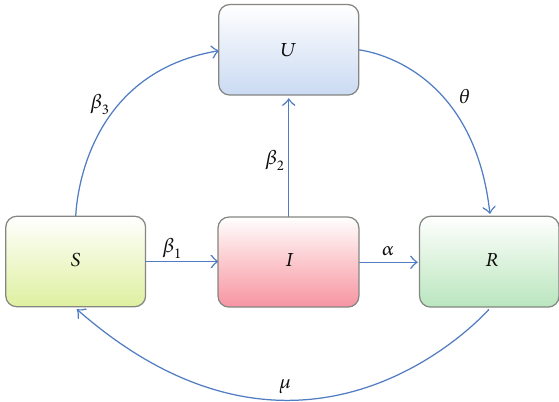
Figure 11: State transition of simplified